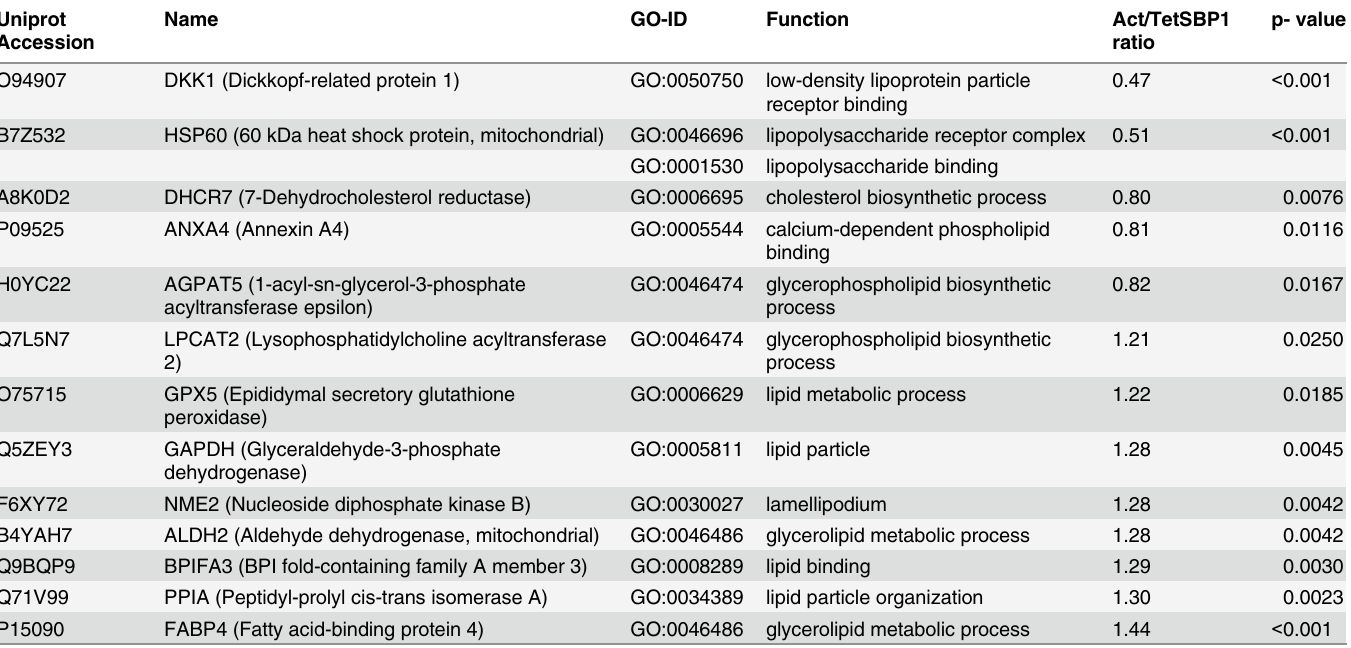
Table 1. Identified differentially accumulated proteins related to lipid metabolism.